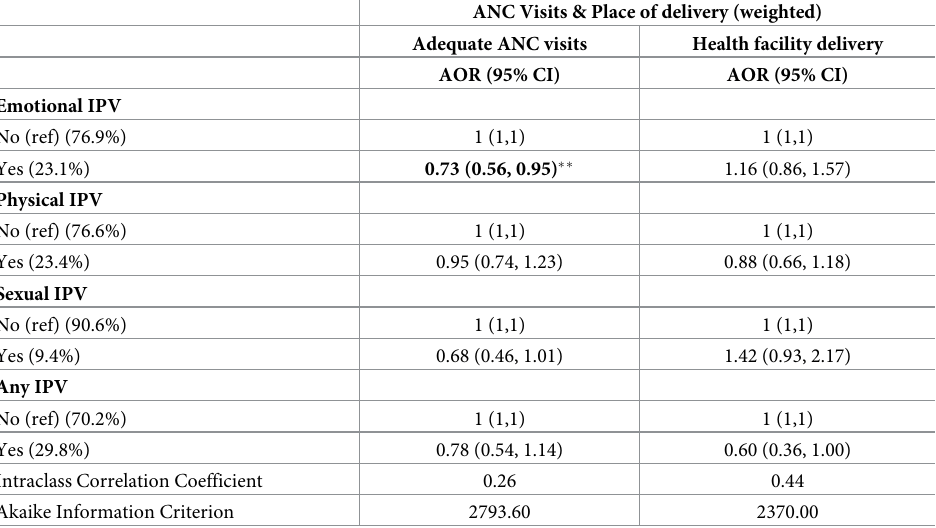
Table 2. Multiple multilevel logistic regression for association between maternal ever exposure to different forms of IPV and use of maternal healthcare services for currently married women. ANC Visits & Place of delivery